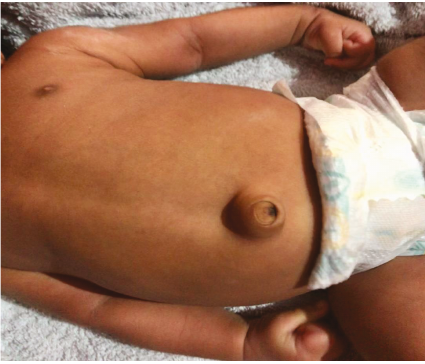
Figure 1: Infantile umbilical hernia. Table 1: The technique of conservative management of infantile umbilical hernia.